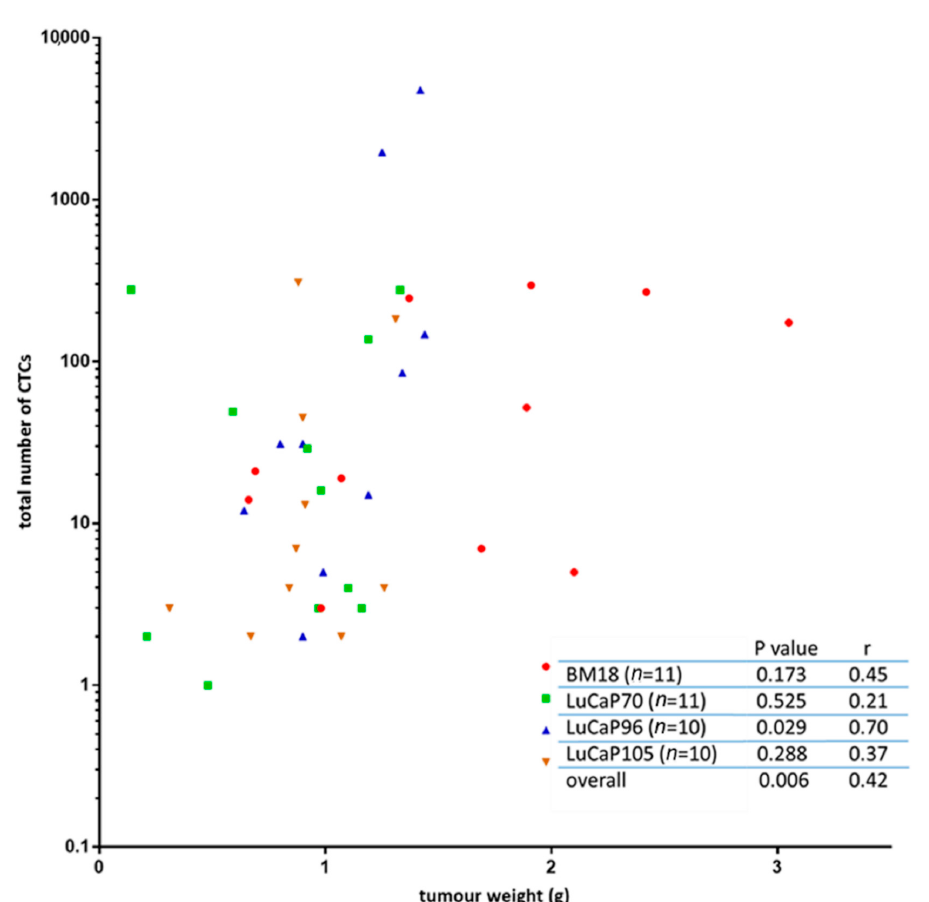
Figure 4. Relationship between tumour weight and number of circulating tumour cells (CTCs). The tumour weight for each mouse was compared to the estimated total number of CTCs in that mouse’s whole blood volume. Limited correlation was identified between the two variables using a non-parametric Spearman correlation and a 95% confidence interval for each model individually, and overall, a significant correlation was observed. Each symbol represents a sample from an individual mouse ( n = 1 per